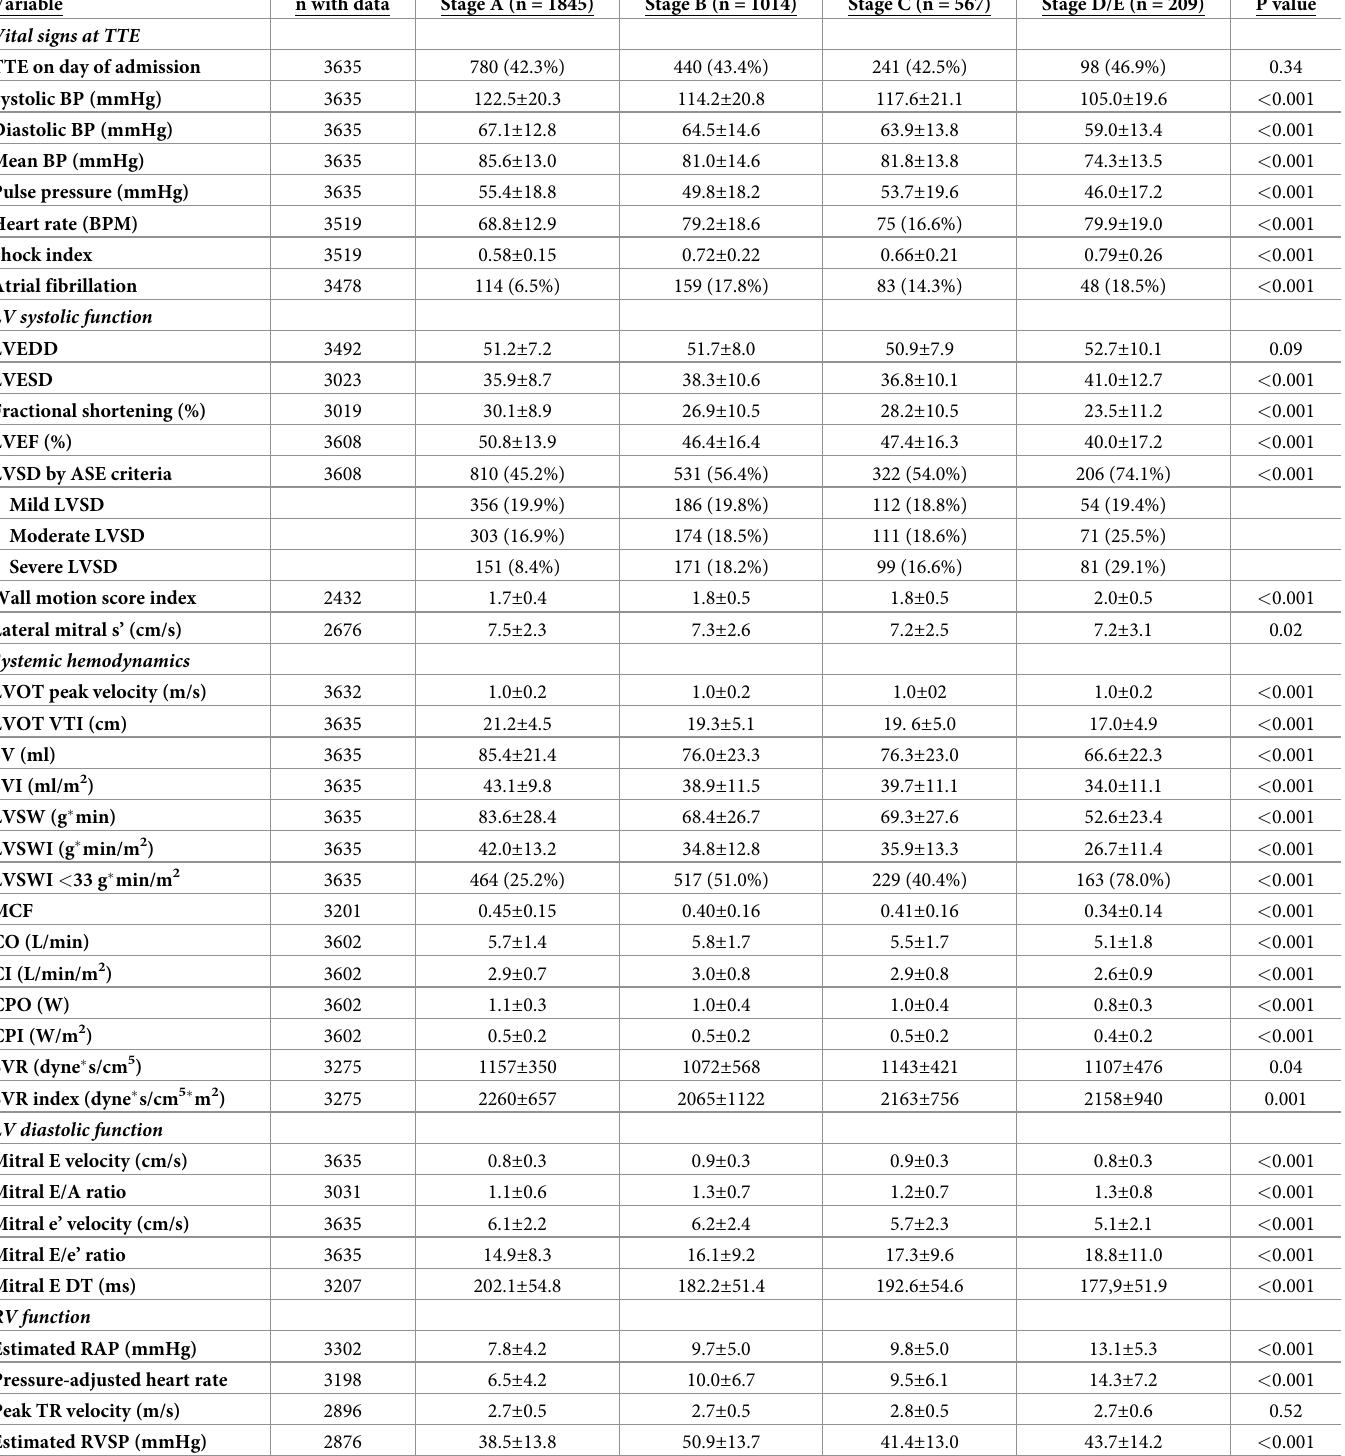
Table 2. Echocardiographic findings of patients according to SCAI shock stages. Data reported as mean ± standard deviation for continuous variables and number (percent) for categorical variables. P value is for linear regression (continuous variables) or logistic regression (categorical variables) across SCAI shock